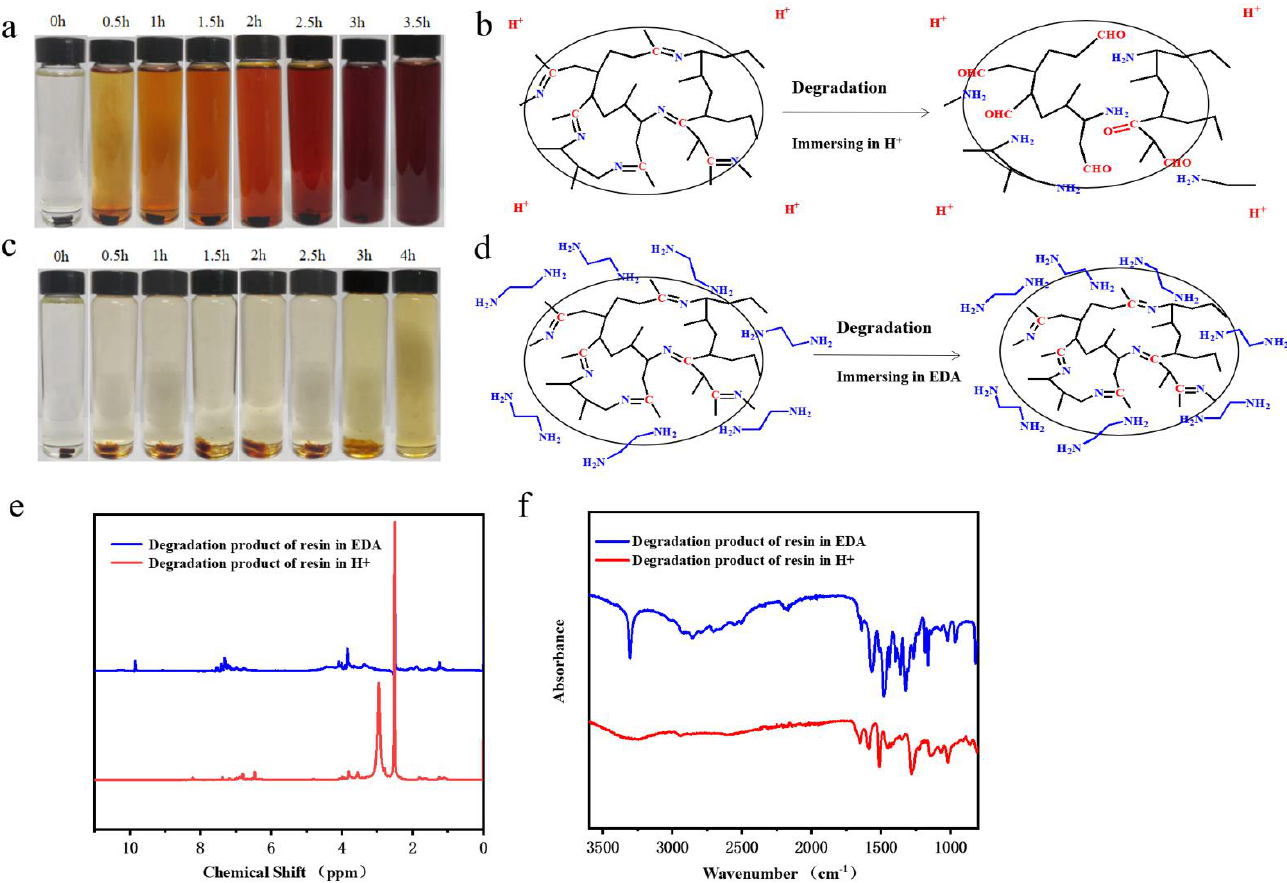
Figure 6. Degradation of VAN-AC-EP/DDM. ( a ) Digital photos of resin in acetone/HCL solution with a volume ratio of 6/4 and ( b ) degradation mechanism. ( c ) Digital photos of resin in EDA and ( d ) degradation mechanism. Structural characterization: ( e ) 1 H NMR and ( f ) FT-IR spectra of VAN-AC-EP/DDM after degradation in H + and EDA.